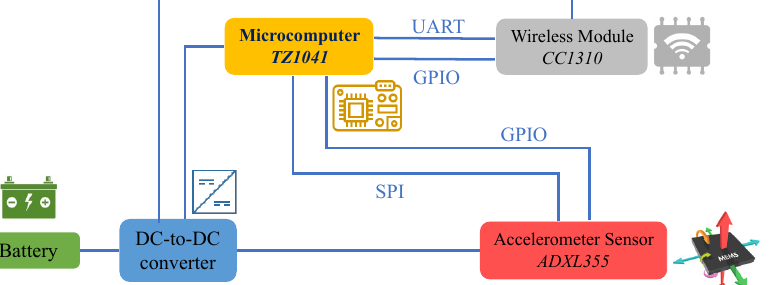
Figure 4. Functional scheme represents the main components present on the wireless sensor board.